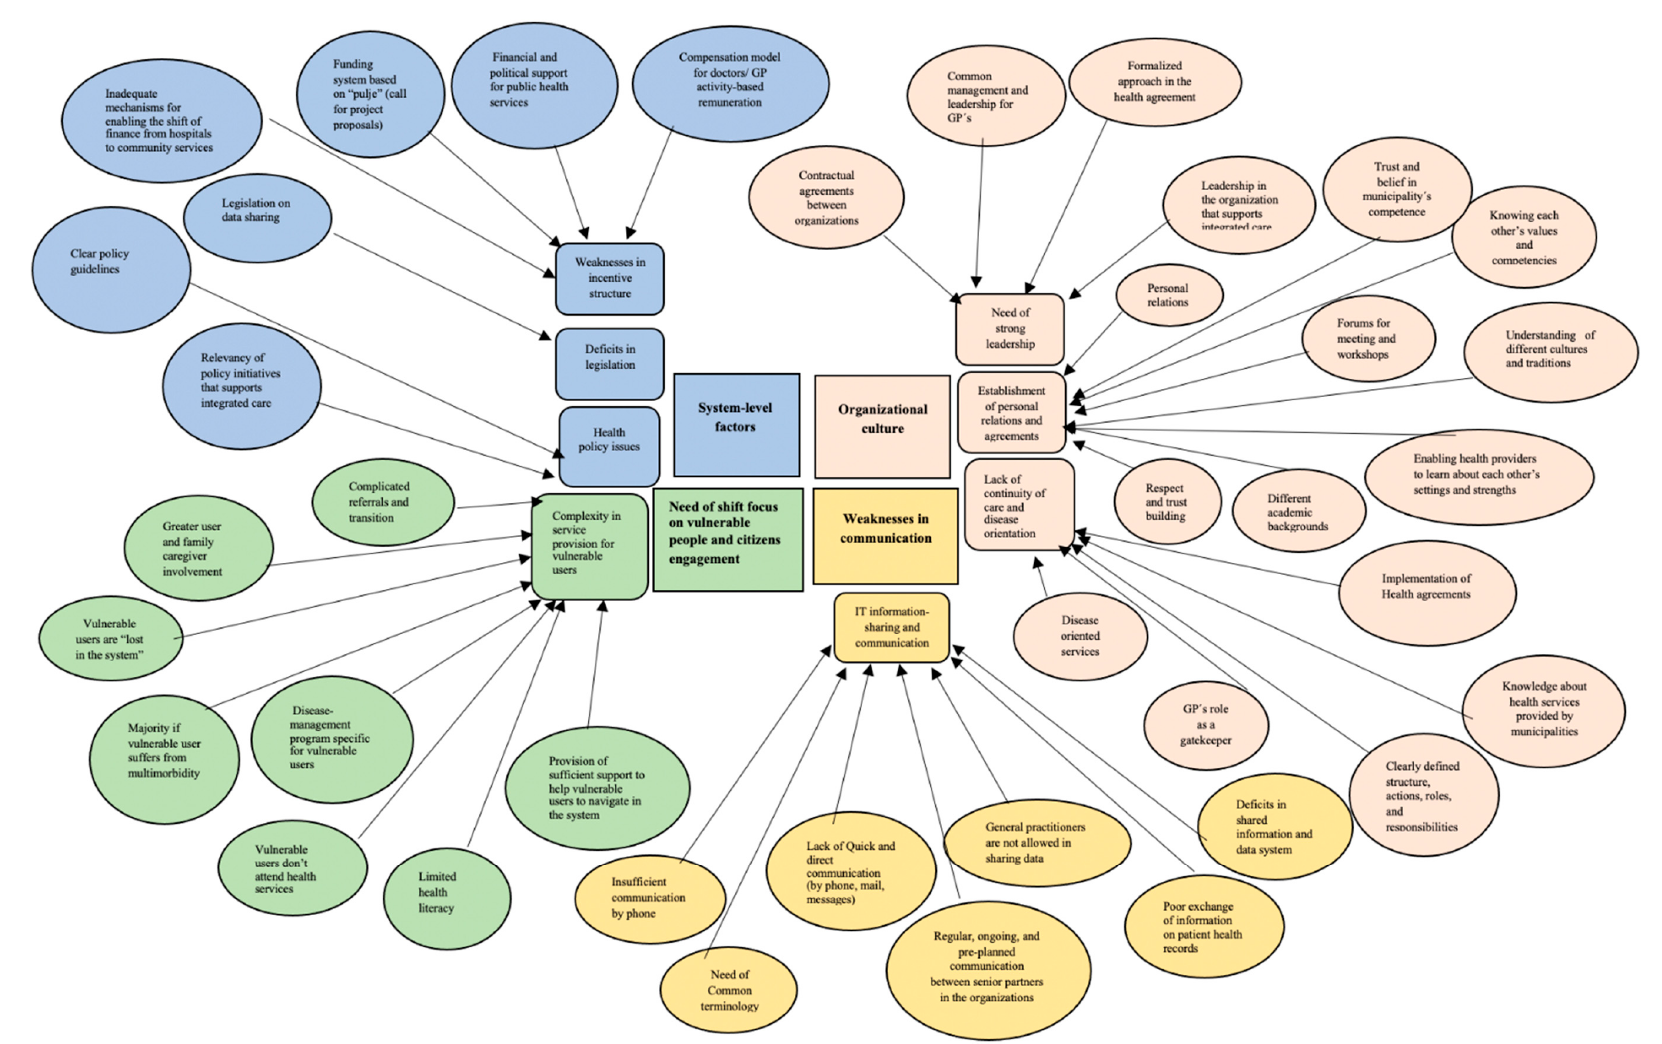
Figure 2. Concept map of providers’ perception about